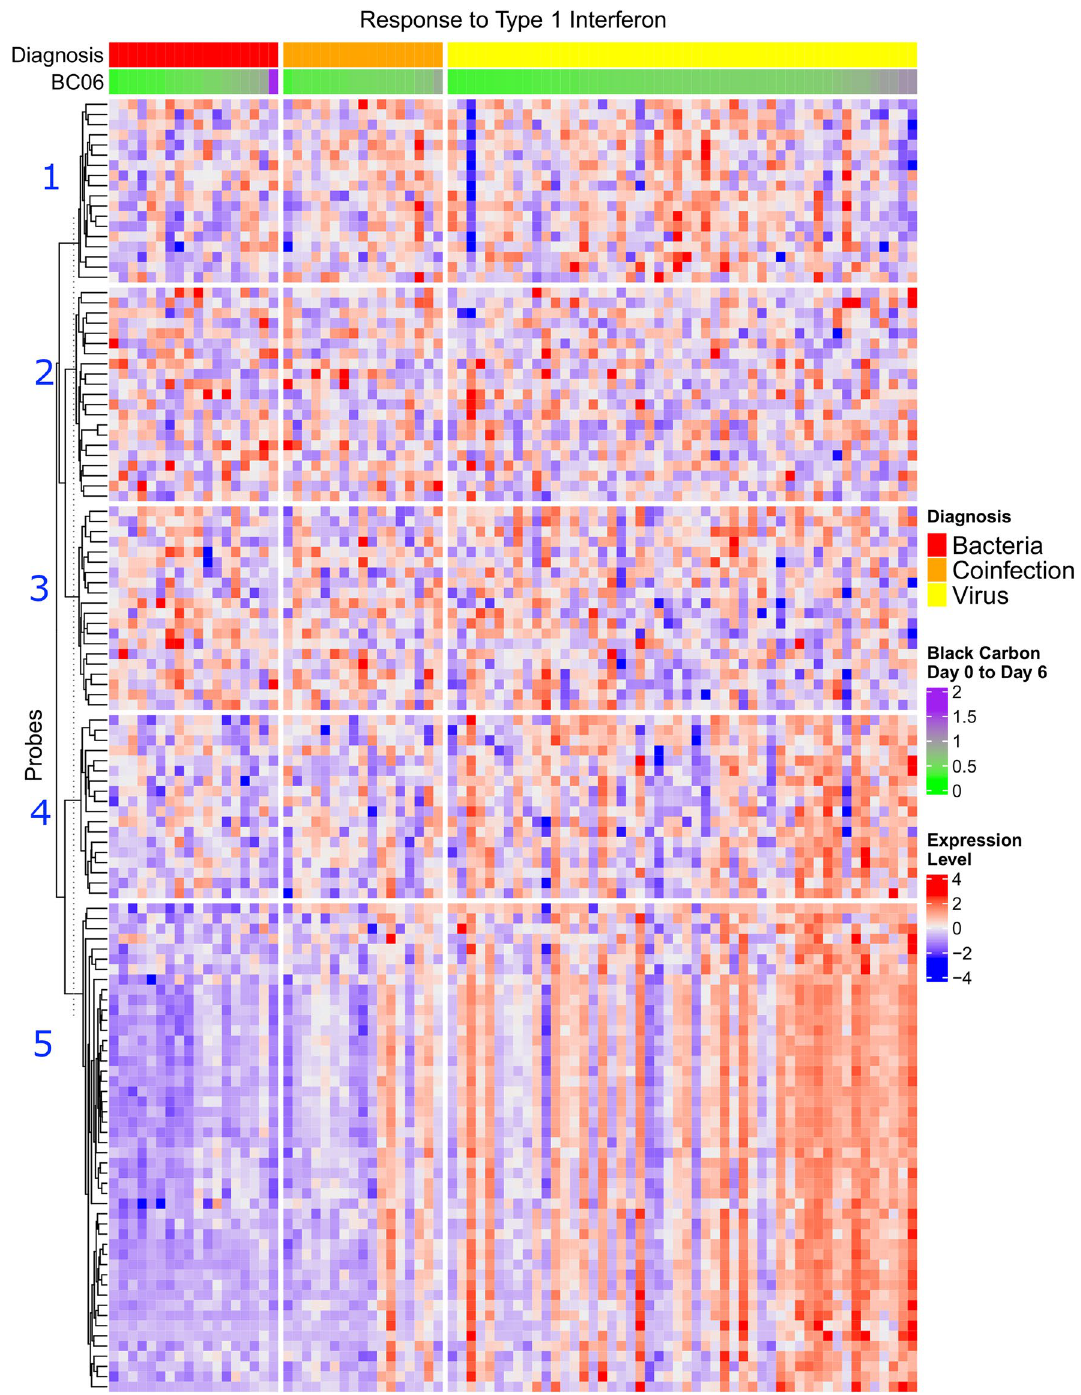
dendrograms generated as in Fig.